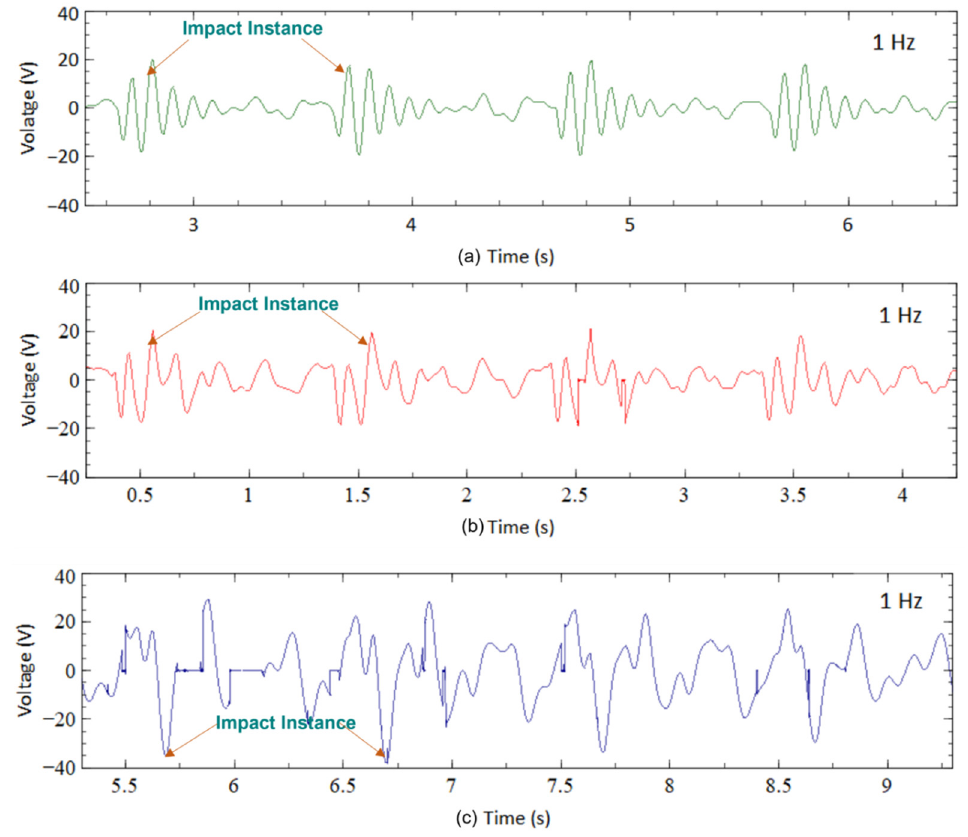
Figure 12. Voltage output of ( a ) CBH, ( b ) VBH, and ( c ) BBBH for human walking (1 Hz).